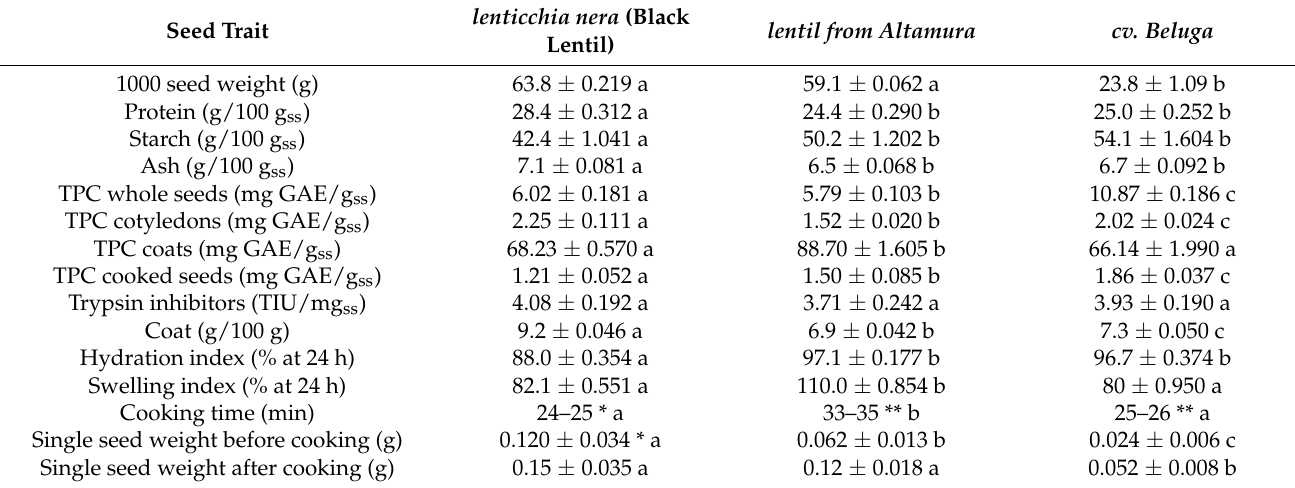
Table 1. Results of physico-chemical and nutritional seed analyses. All values are expressed on dry seed weight base. lenticchia nera (Black Seed Trait